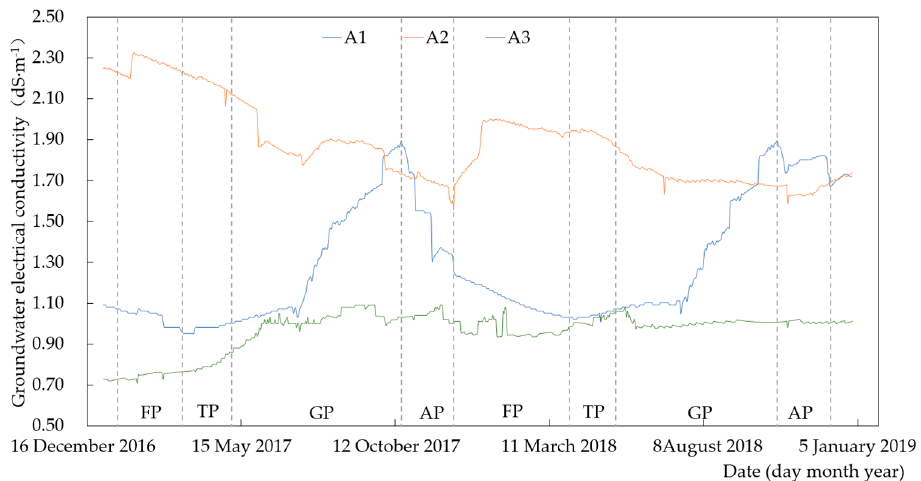
Figure 9. Dynamics of groundwater electrical conductivity in 2017–2018.